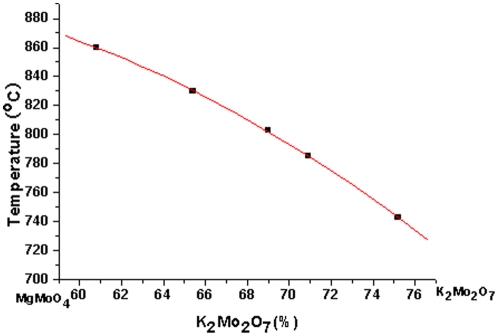
Solubility curve of MgMoO4 in MgMoO4-K2Mo2O7 system.